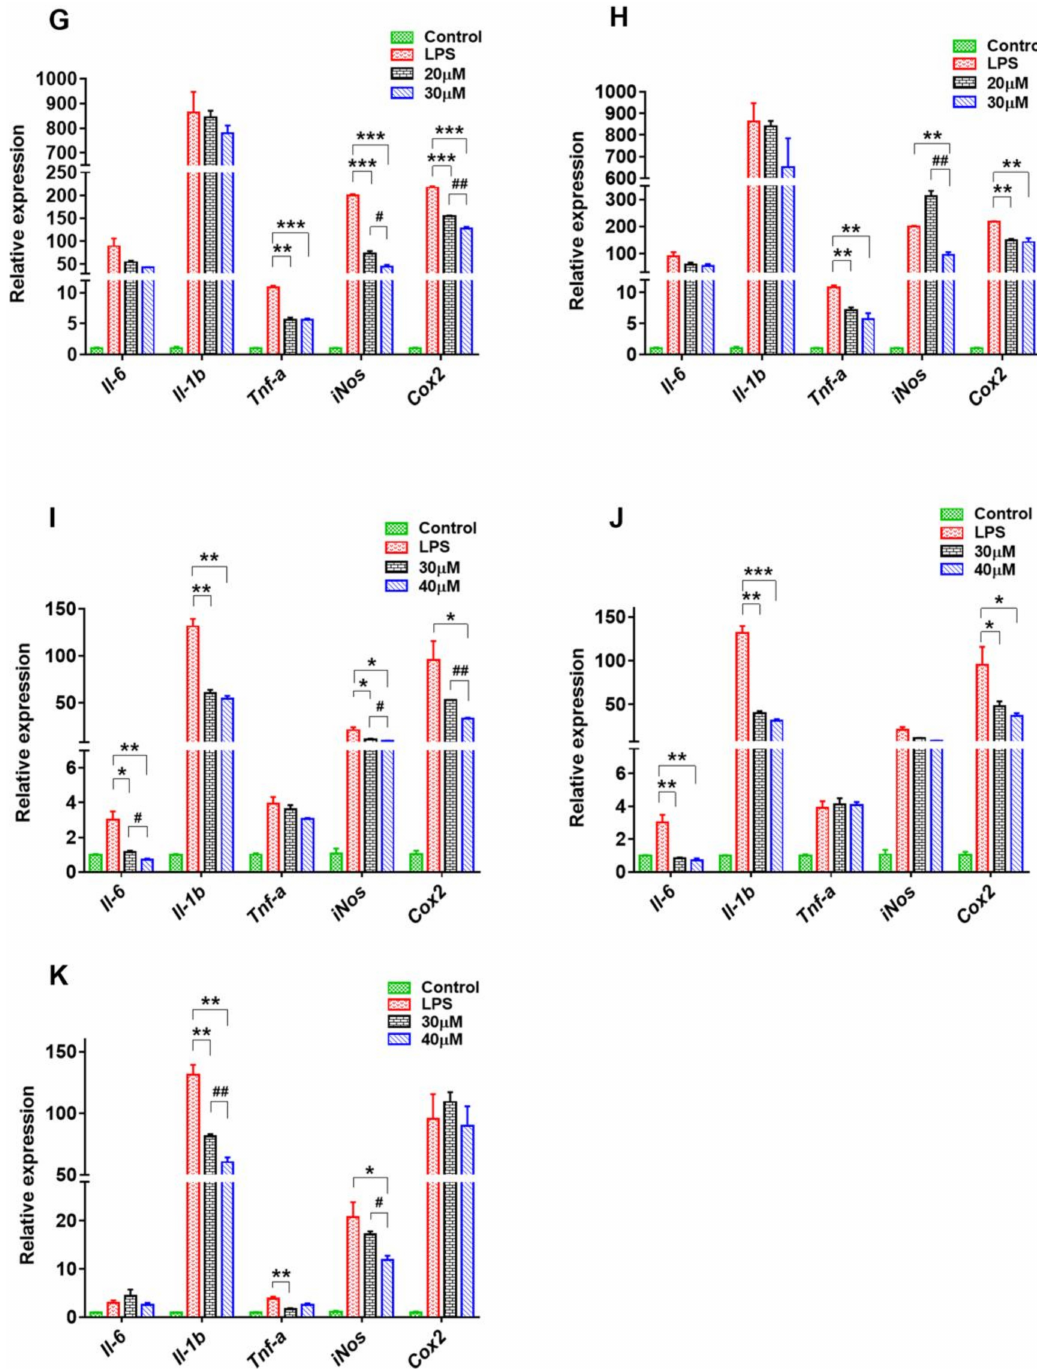
Figure 5. E ff ect of compounds 9 – 13 ( G – K ) on the mRNA levels of IL-6, IL-1 β , TNF- α , iNOS, and COX-2 in RAW264.7 cells stimulated by LPS. Data are presented as means ± SEM, n = 3; * p < 0.05, ** p < 0.01, *** p < 0.001, treatment vs. LPS model; # p < 0.05, ## p < 0.01, ### p < 0.001, high concentration vs. low